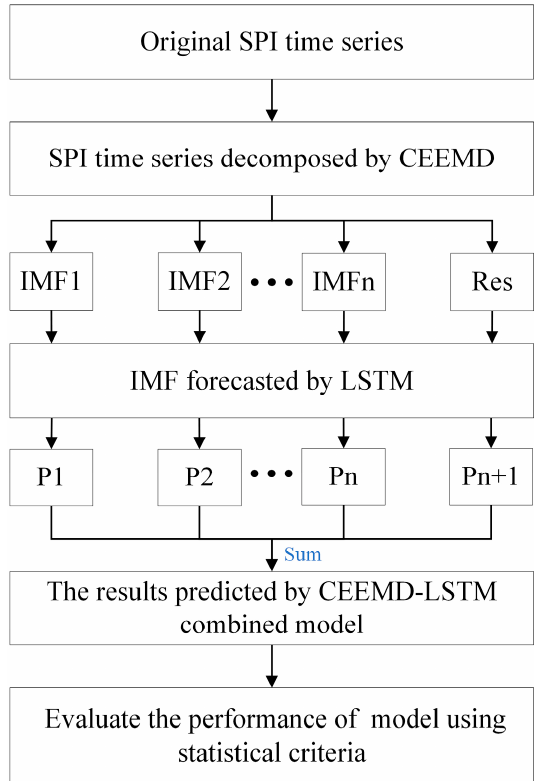
Figure 3. Workflow of the CEEMD-LSTM combined model.